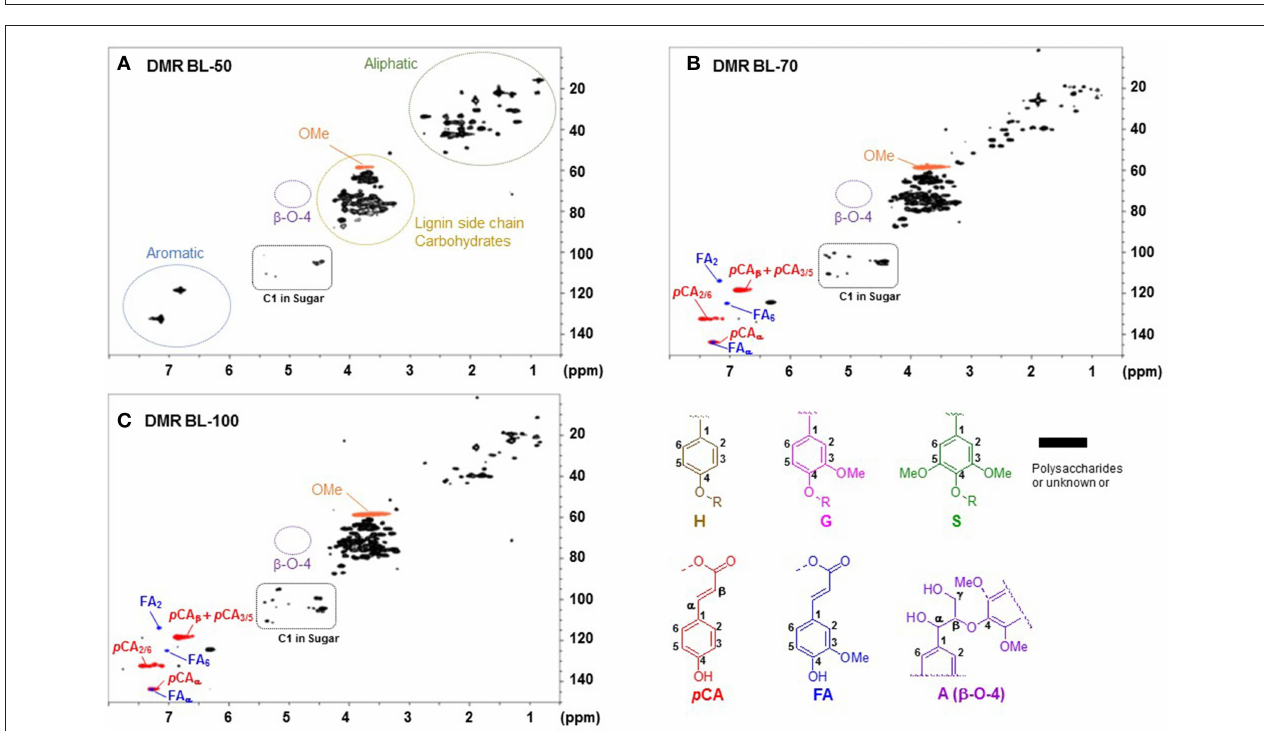
in deacetylation process, breaking down xylooligomers is our priority. We expect that appropriate application of enzymes could be able to convert xylooligomers to xylose thus it could